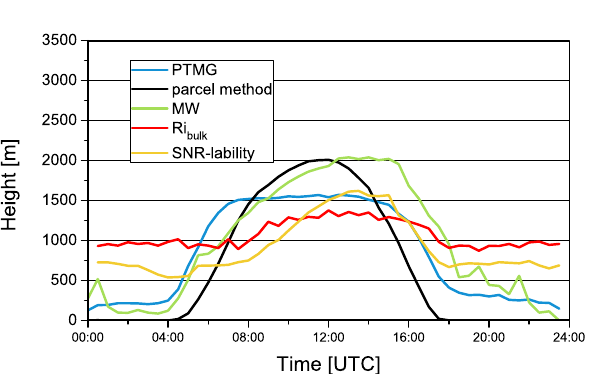
Figure 3. Average (July–September, 2012) diurnal course of PBL height using WRF-SCM model.